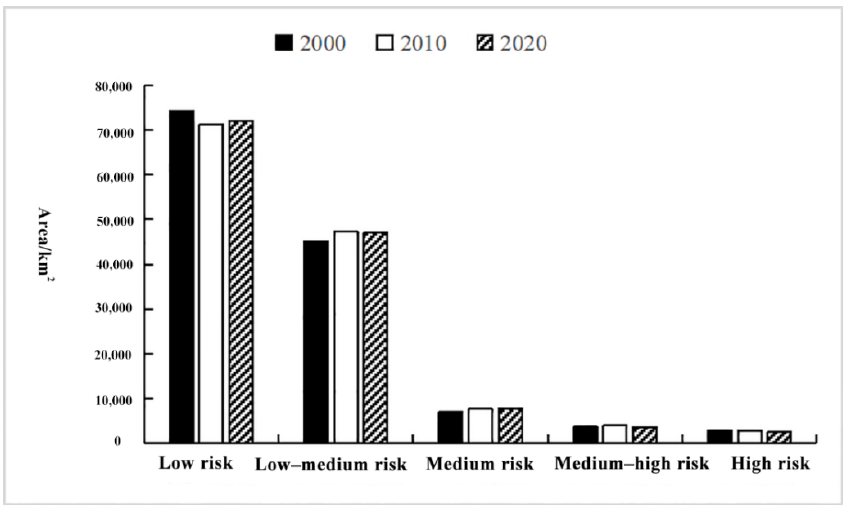
Figure 6. Area (km 2 ) change of landscape ecological risk area of the Yellow River Basin, Shaanxi Province from 2000 to 2020.